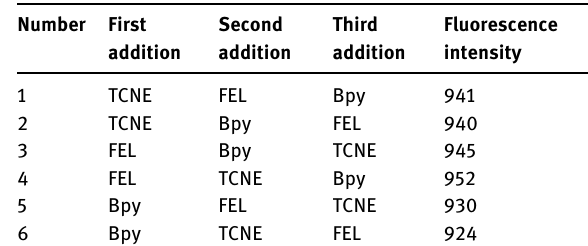
Table 1: E ff ect of adding di ff erent reagent sequence on fl